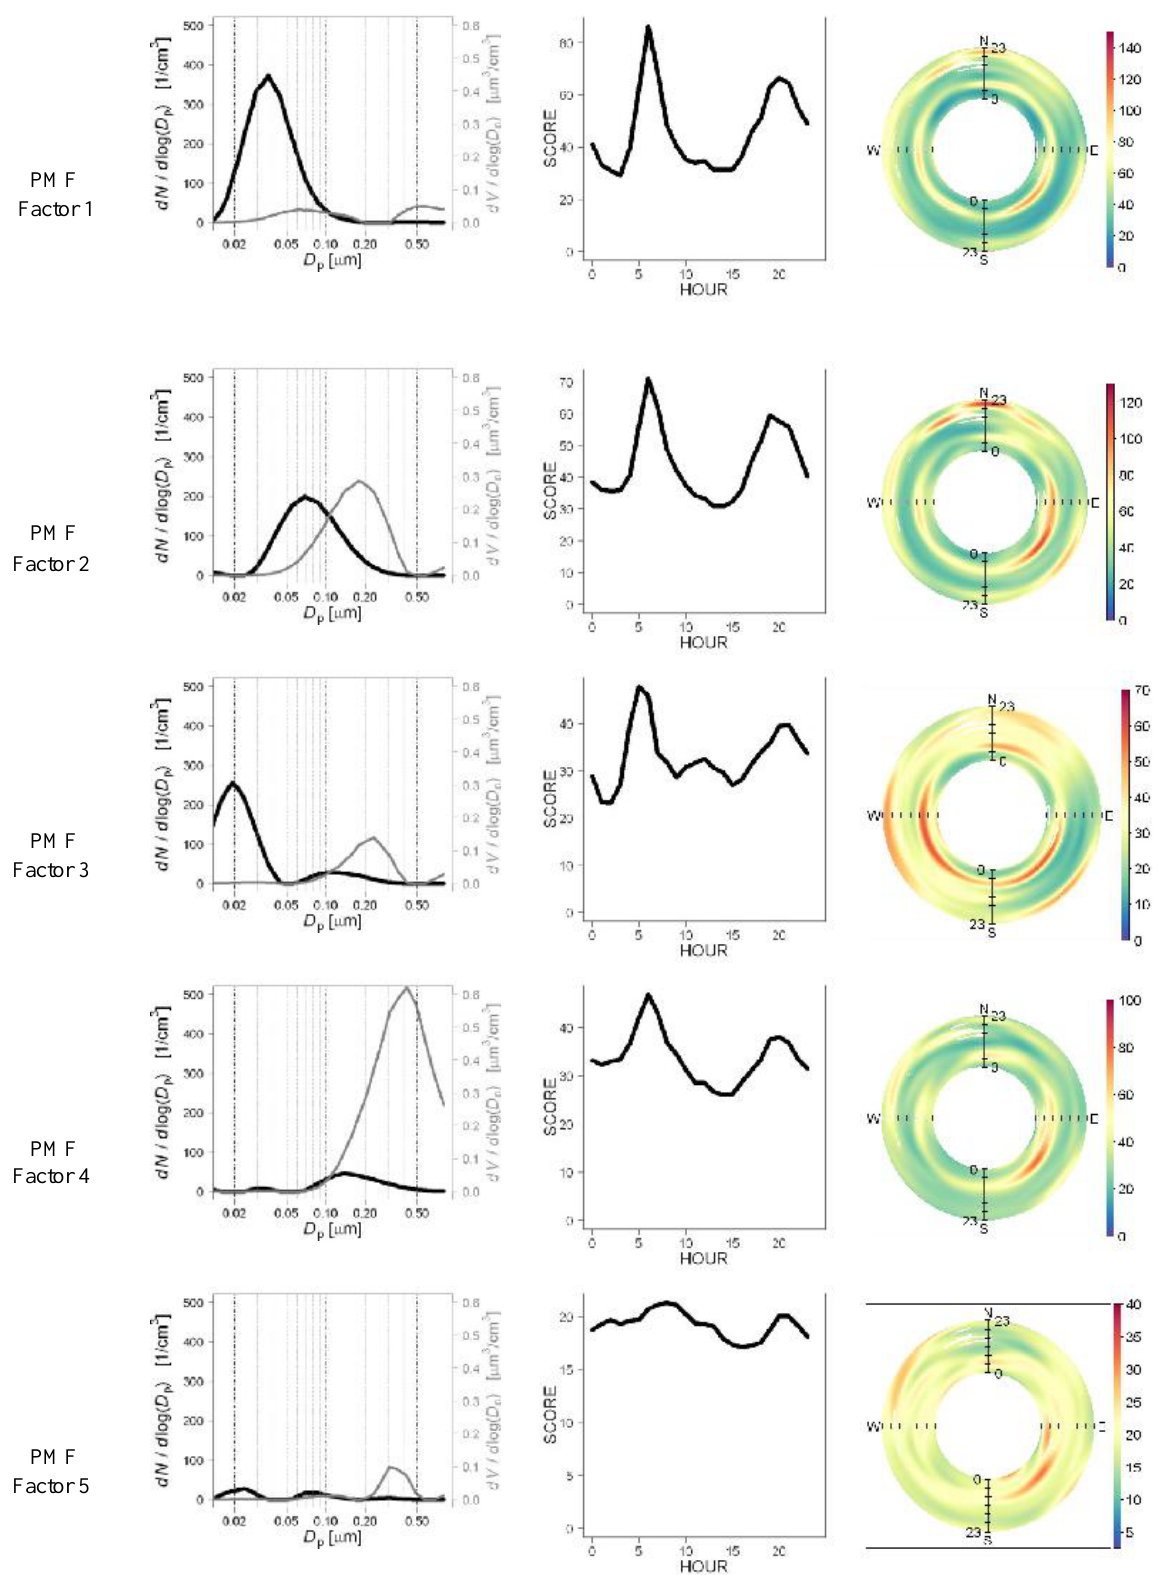
2 Fig. 7. Aerosol number (dark line, d N/ d log( D p )) and volume (pale line, d V/ d log( D p )) size-resolved size distributions, diurnal patterns and wind roses for the five factors obtained by the PMF